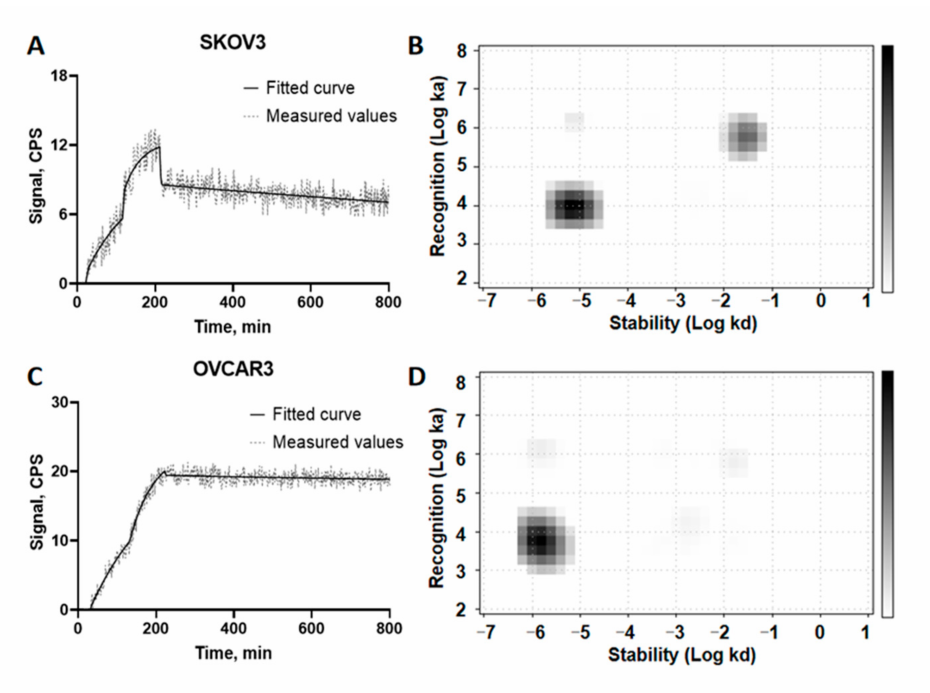
Figure 4. Binding kinetics of [ 125 I]I-Ec1-LoPE to ( A ) SKOV3 cells and ( C ) OVCAR3 cells analyzed by TraceDrawer and corresponding interaction maps ( B , D ). Data are representatives from